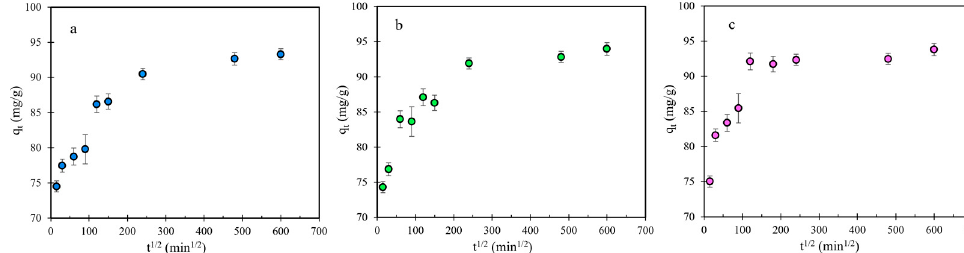
Figure 7. Kinetics of MB adsorption by intra-particle diffusion model under ( a ) dark, ( b ) green light, and ( c ) purple light conditions.